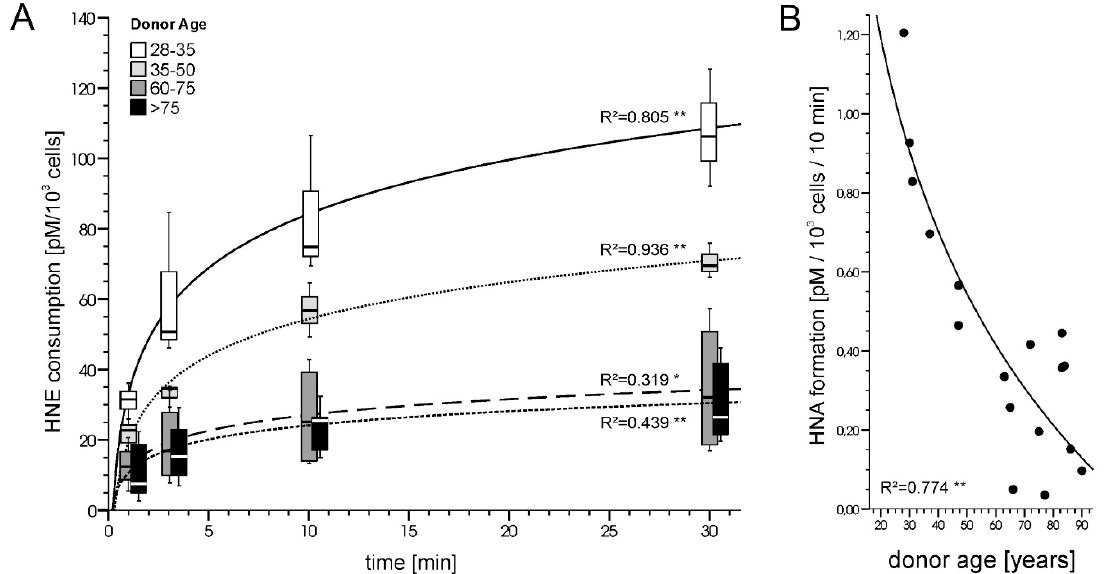
Figure 1. Age dependence of HNE metabolism in cultured human skin fibroblasts. Cell cultures were established from donors of different ages and treated with 1 µM HNE. ( A ) HNE consumption curves (expressed as pM HNE per 10 3 cells) determined 1, 3, 10 and 30 min after HNE addition. Data of the age cohorts are presented as Box-Whisker Plots. ( B ) Formation of hydroxynoneoic-acid (HNA) from HNE in the fibroblast cultures expressed as pM HNA/10 3 cells/10 min). * p < 0.05; ** p < 0.005 significance of the correlation (Pearson): [Siems W., Voss P., Bresgen N., Eckl P. and Grune T., unpublished data] [19] .